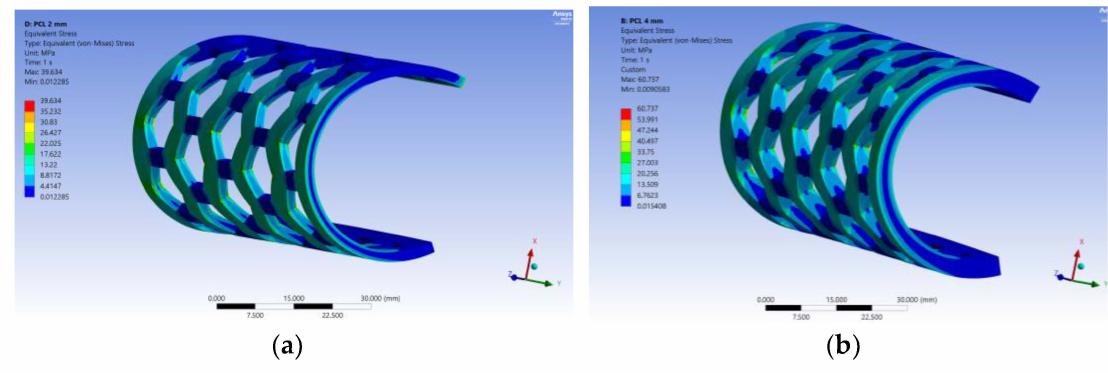
Figure 15. The resulting stress for the model of 2 mm thickness ( a ) and 4 mm thickness ( b ).